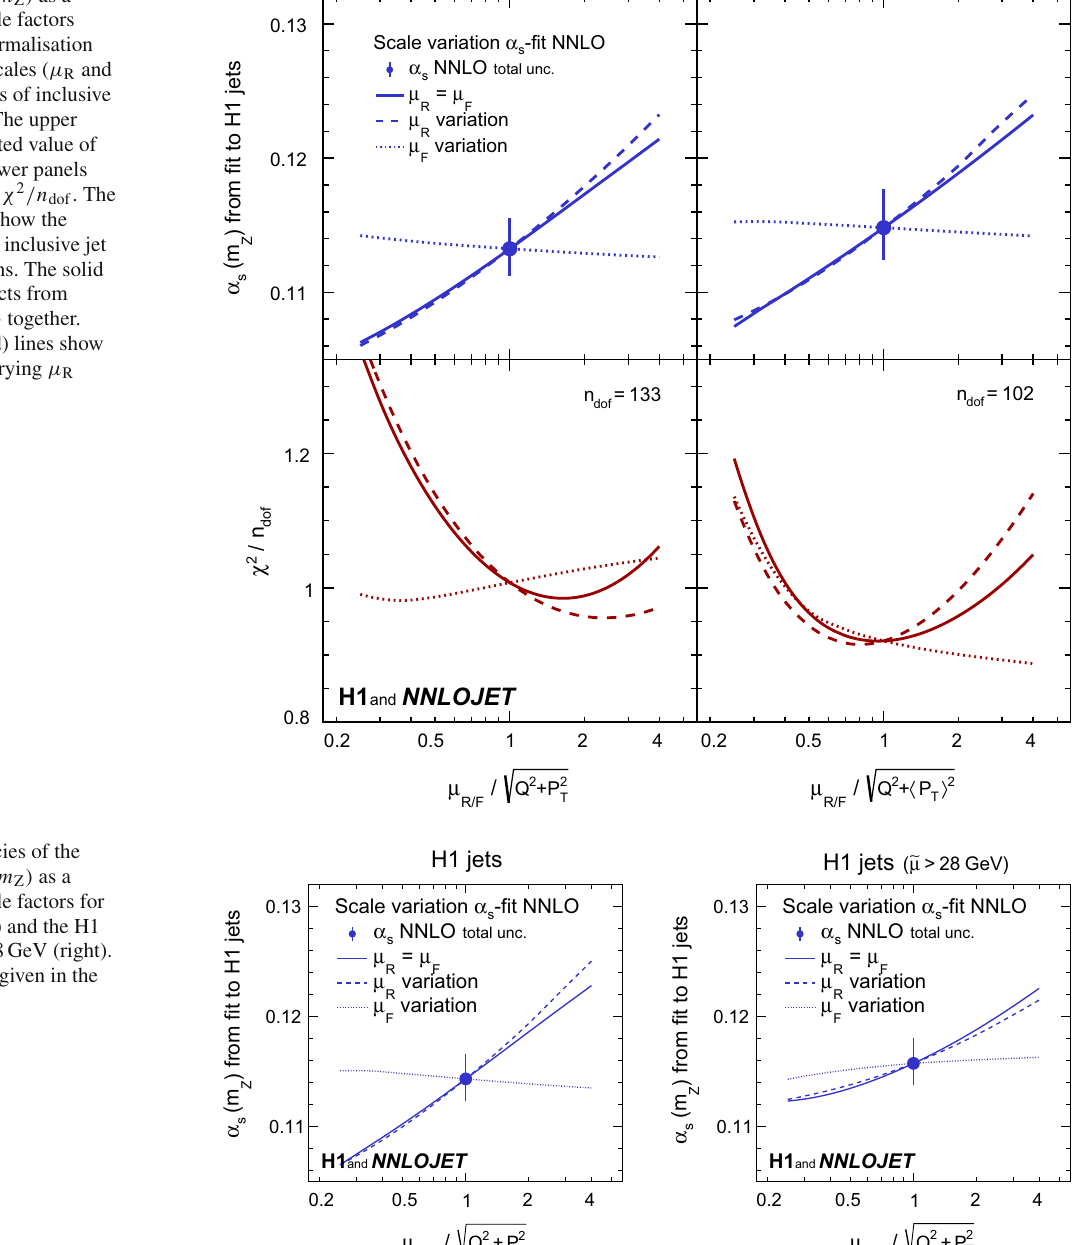
Fig. 6 Dependencies of the fitted values of α s ( m Z ) as a function of the scale factors applied to the renormalisation and factorisation scales ( μ R and μ F ) for separate fits of inclusive jet and dijet data. The upper panels show the fitted value of α ( m ) , and the lower panels s Z show the values of χ 2 / n dof . The left (right) panels show the values for the fit to inclusive jet (dijet) cross sections. The solid lines show the effects from varying μ R and μ F together. The dashed (dotted) lines show the effects from varying μ R ( μ F ) alone